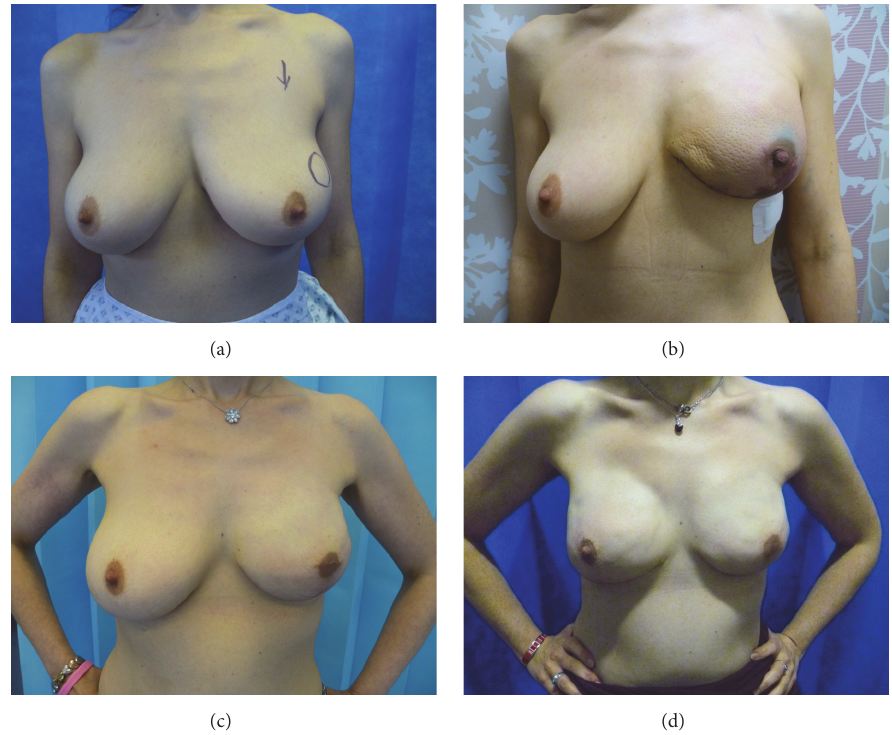
Figure 3: 40-year-old lady with left breast cancer (Case 2). (a) Pre-op photograph with skin mark showing the site of cancer in upper outer quadrant of left breast. She has bilateral pseudoptosis. She smoked (1-2 per day) at presentation. (b) Immediate post-op after left NSMx and implant reconstruction. She developed superficial skin necrosis of the skin flap on the inferior aspect that was managed conservatively. The nipple shaves on left side were positive for DCIS. She underwent nipple excision under local anesthetic. (c) The left breast reconstruction after nipple excision. (d) Post-op photograph after right risk-reducing NSMx with one-stage implant reconstruction, 15 months after the surgery on left side. There is a degree of capsular contracture on left side due to radiotherapy.